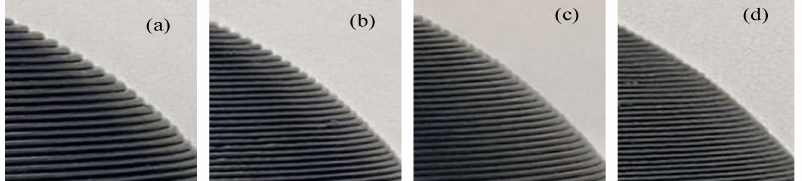
Figure 12. Partial details of the hemispherical model. ( a ) Slicing thickness is 0.4 mm. ( b ) Slicing thickness is 0.3 mm. ( c ) Slicing thickness is 0.2 mm. ( d ) Partial detail of adaptive layering based on optimal volume error.